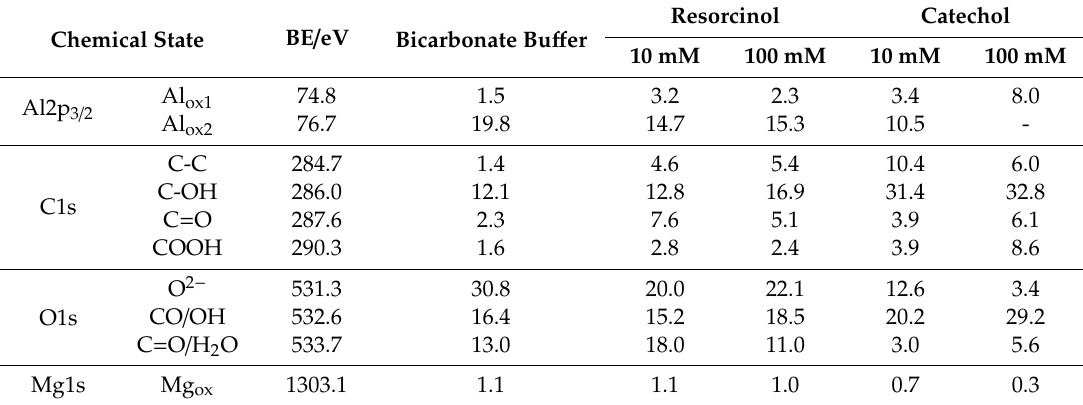
Table 2. Surface chemical composition (in at.%) for AA5754 after 24 h exposure in bicarbonate bu ff er (pH = 11) with the addition of resorcinol or catechol, based on high-resolution XPS analysis. Chemical State BE / eV Bicarbonate Bu ff